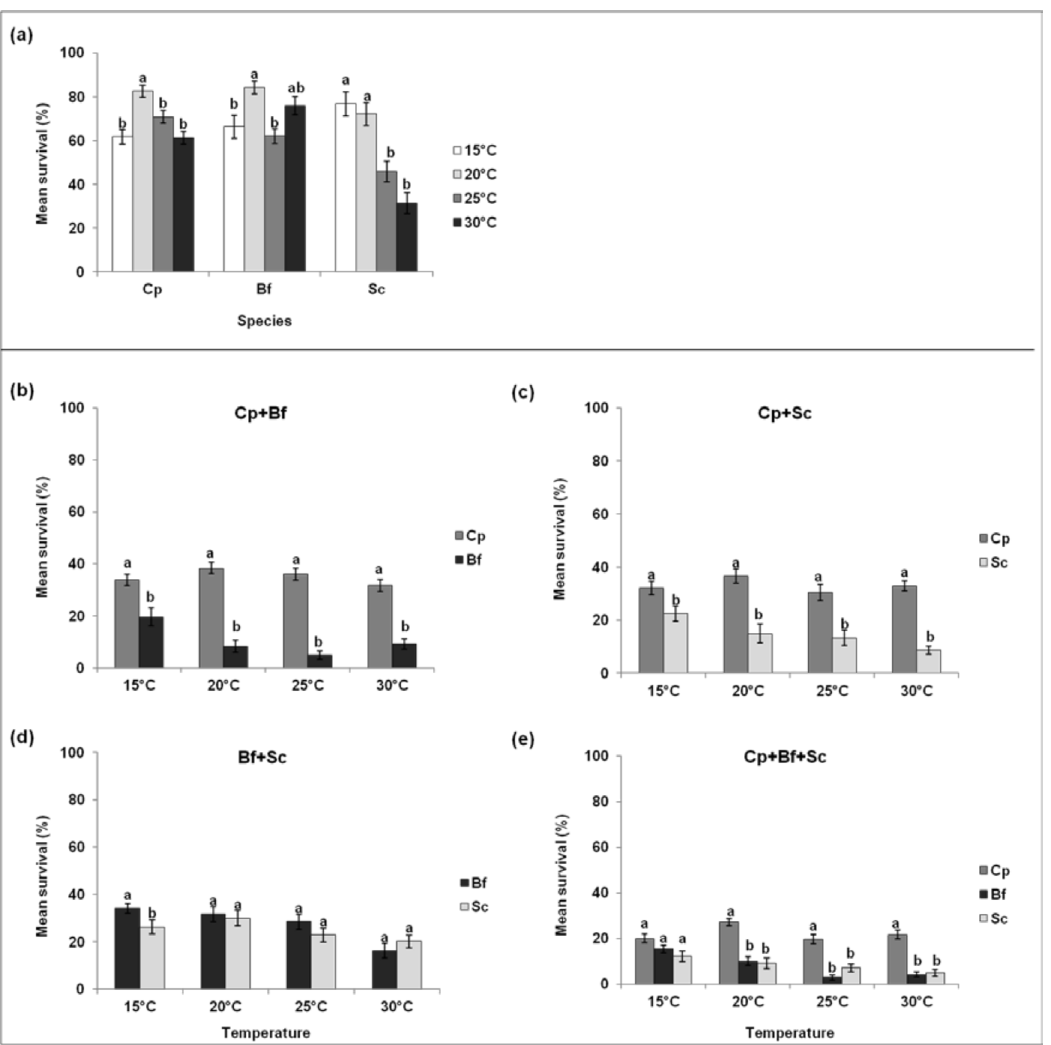
Fig 4. Comparison of survival of Chilo partellus (Cp), Busseola fusca (Bf) and Sesamia calamistis (Sc) larvae as single-species (a) and between borer species in multi-species communities at different constant temperatures (b-e) . Means ( ± SE) with different letters are significantly different at 5% level. GLM (binomial).